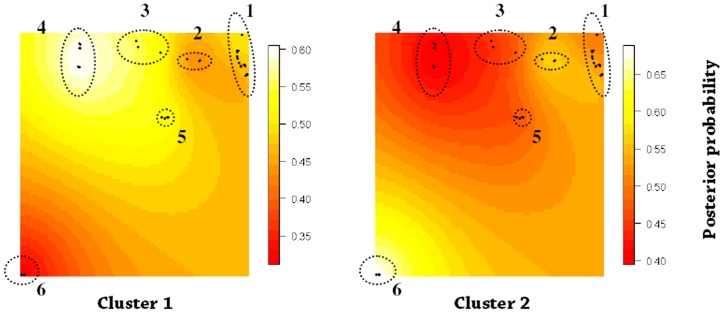
Spatially explicit predictive map of admixture coefficients as determined by TESS for 2 clusters, Kmax = 2.The colour scale represents the posterior probability of individuals having membership to a single genetic cluster. Black circles represent sampled individuals with known geographic locations (n = 72). Numbered ellipses indicate the populations; 1 = Hattah-Kulkyne, 2 = Murray-Sunset (East), 3 = Murray-Sunset (Central), 4 = Murray-Sunset (West), 5 = Murray-Sunset (South) and 6 = Ngarkat Conservation Park.